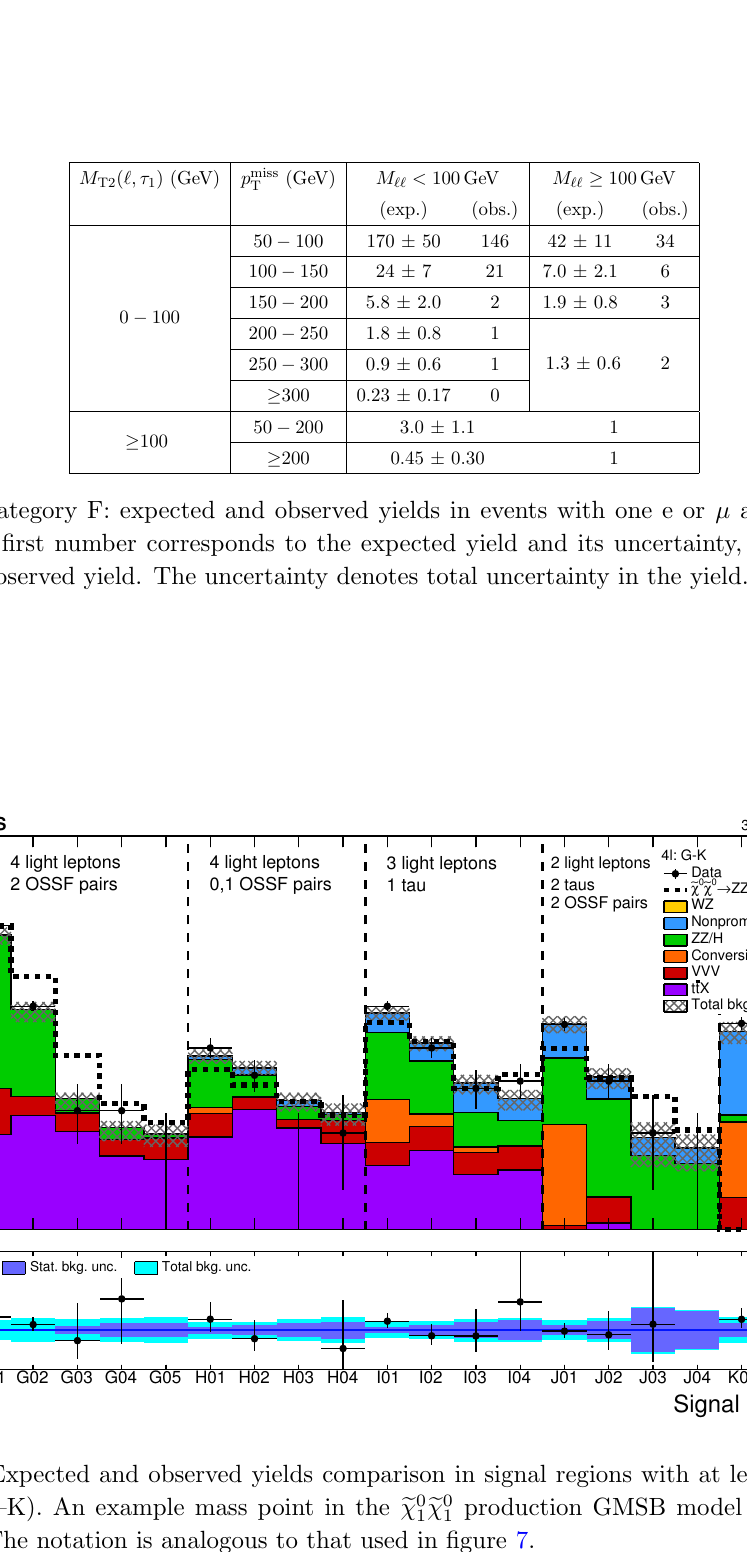
(cid:31) 0 (cid:31) 0 production GMSB model is displayed for 1 1 e e